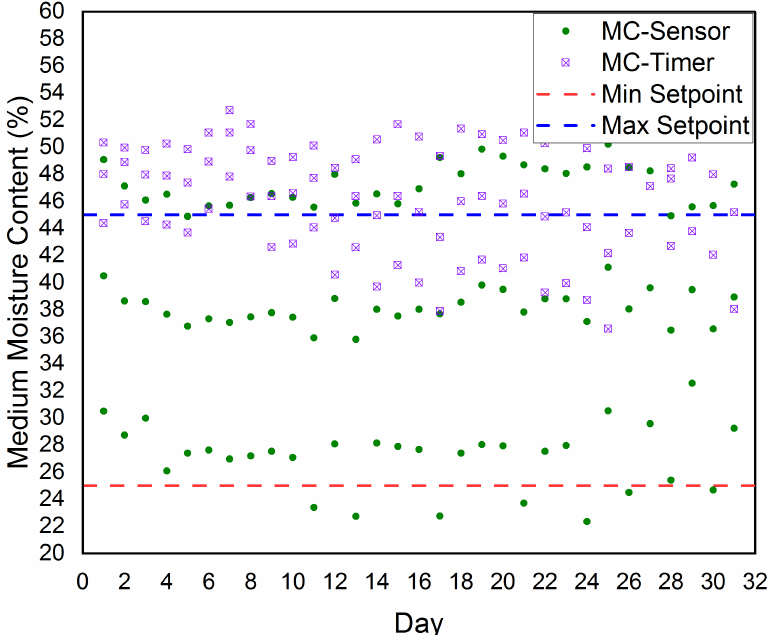
Figure 11. The three months average for the sensed growth medium moisture content (MC-Sensor) and irrigation timer (MC-Timer) according to the minimum setpoint (Min Setpoint) and maximum setpoint (Max Setpoint) considered in our platform.